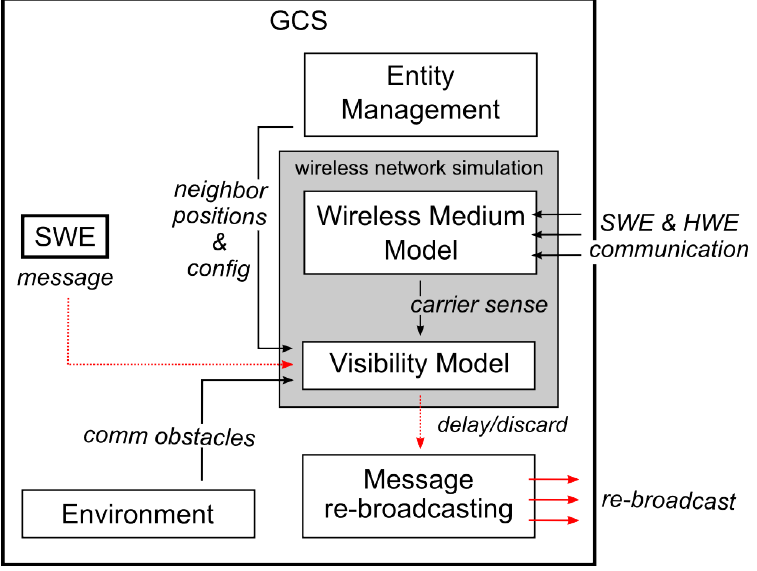
Figure 5. Visibility model for SWEs within the simulation platform (GCS) showing procesing of a message from one